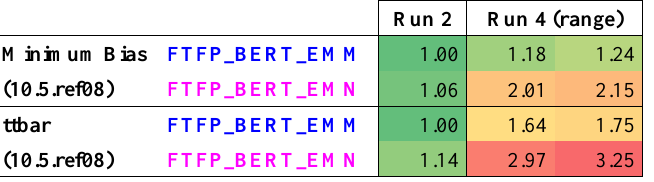
Figure 1. Detector simulation CPU usage for two di ff erent processes, minimum bias and tt, comparing two di ff erent physics lists and the Run 2 and Run 4 CMS geometries. The value for each entry is normalized to the Run 2 ftfp _ bert _ emm value for the corresponding